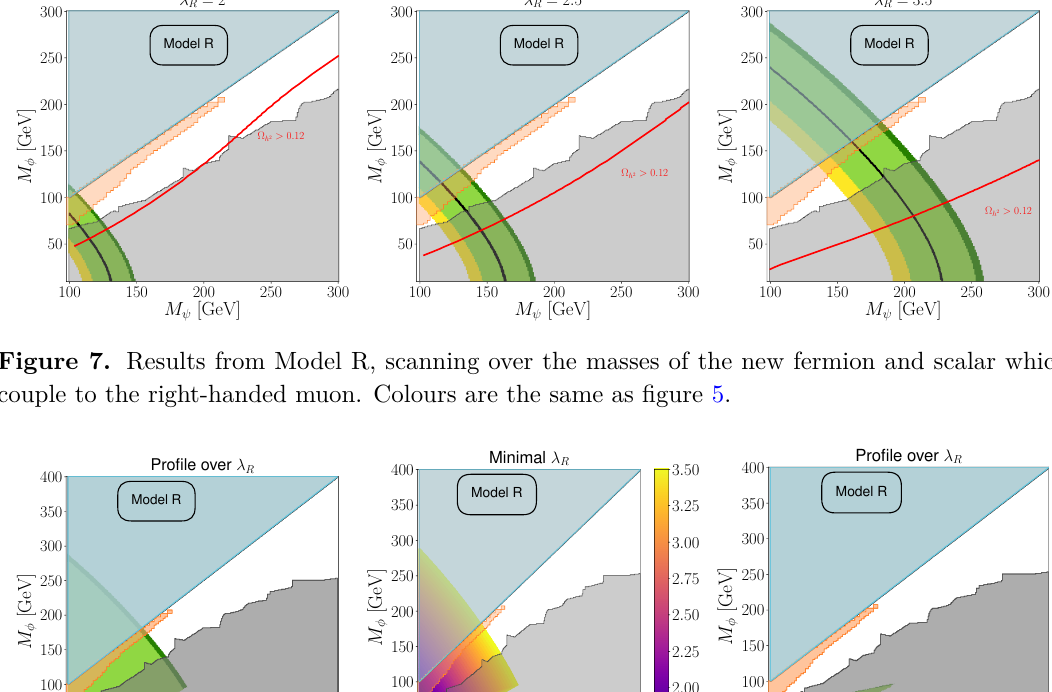
which can explain a 2021 from eq. (1.7) R µ